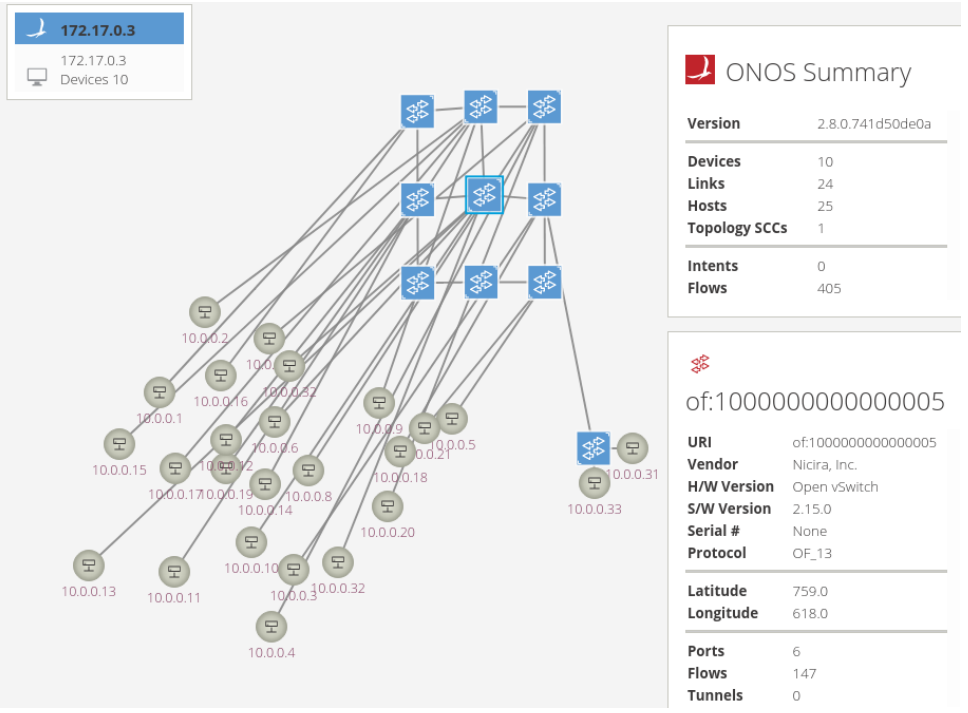
Figure 6. A sample network topology in the